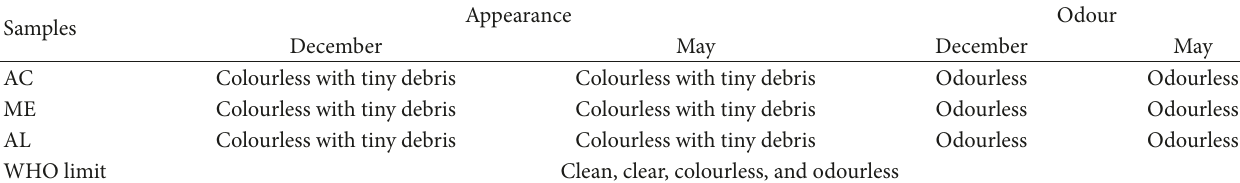
Table 1: Results of organoleptic parameters.